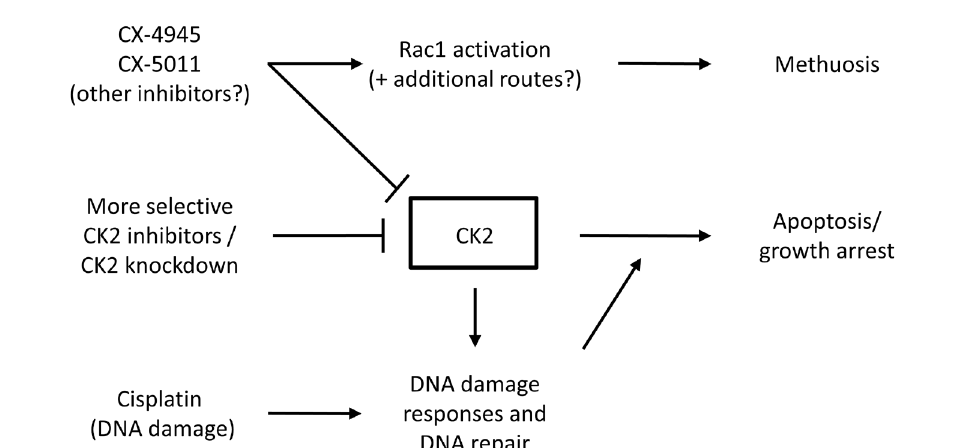
Figure 2. CK2 inhibitors induce cell death by multiple mechanisms. A schematic representation of the effects of CK2 inhibitors on cell fate. Methuosis is a rapid response to some CK2 inhibitors occurring within a few hours. Apoptosis is a slower response to CK2 inhibition occurring after 24 h or more. CK2 inhibition in conjunction with chemotherapeutic drugs that induce DNA damage results in increased levels of cell death and this may be useful in cancer treatment Drug